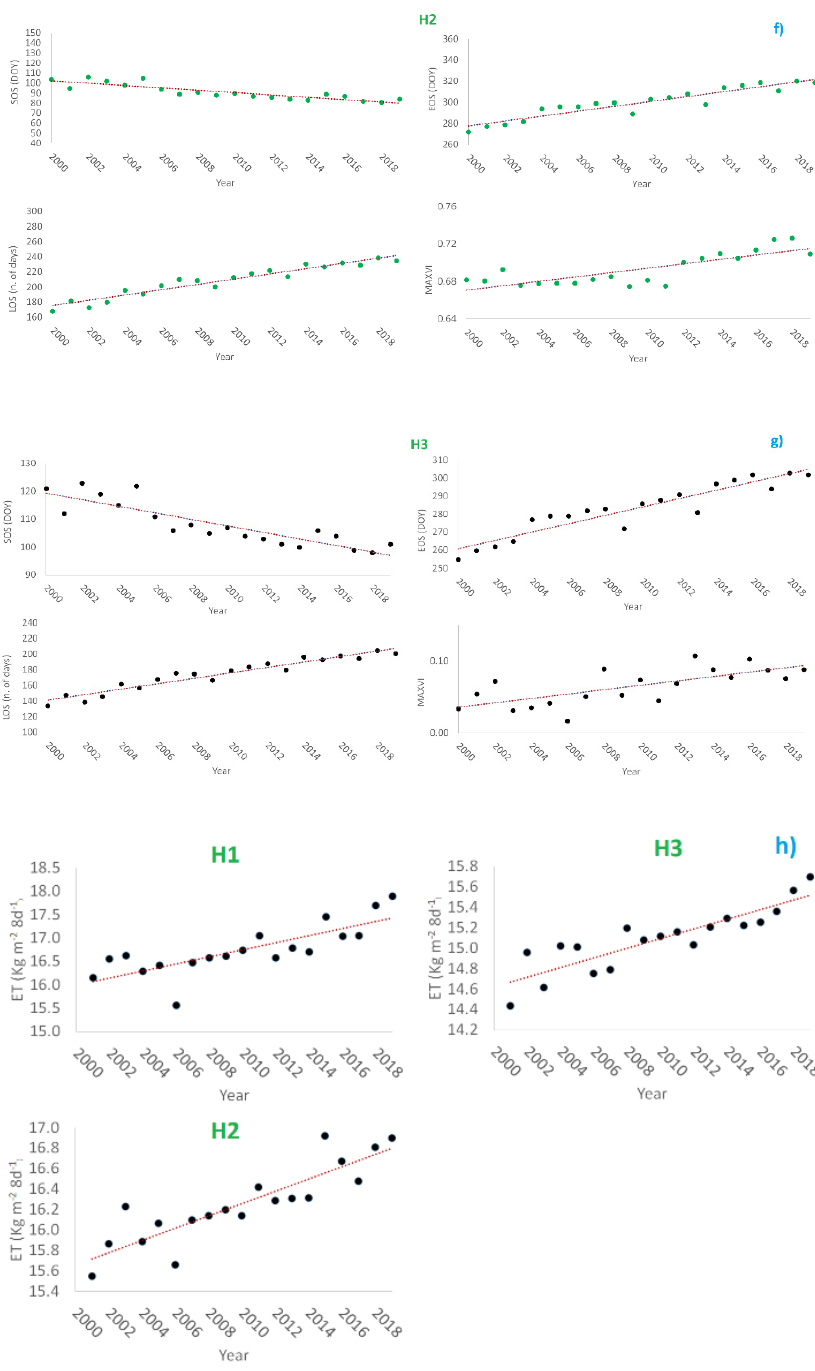
Figure 4. Height classes (H1, H2, H3) mean values of PMs (SOS, EOS, LOS, MAXVI) as estimated by TIMESAT 3.3 with STL ( a , b , c ) refer to rangelands while ( e , f , g ) refer to broad-leaved forests. ( d ) and ( h ) refer to, respectively, rangelands and broad-leaved forests ET values. Height class (H1, H2, H3) yearly mean values of ET. Reported values correspond to the yearly mean value of the 8 days aggregated data from MOD16A2 product. In all the graphs orange points represent outliers (see Equation (2)). All the trends proved to be significant (see Table 4B). DOY: day of the year. According to Equation (3), the number of outliers was found to be lower than four (orange points in Figure 4) for all considered parameters (PMs and ET). After, the outlier removal of PMs and ET trends turned to be statistically significant.